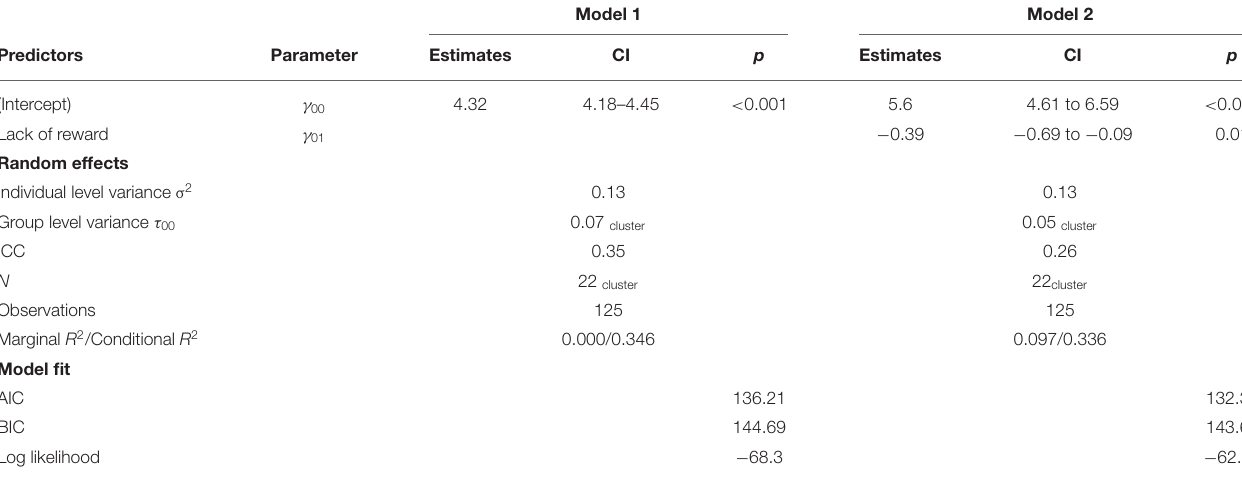
TABLE 6 | Variance component models for efficacy expectations in workshops ( N =